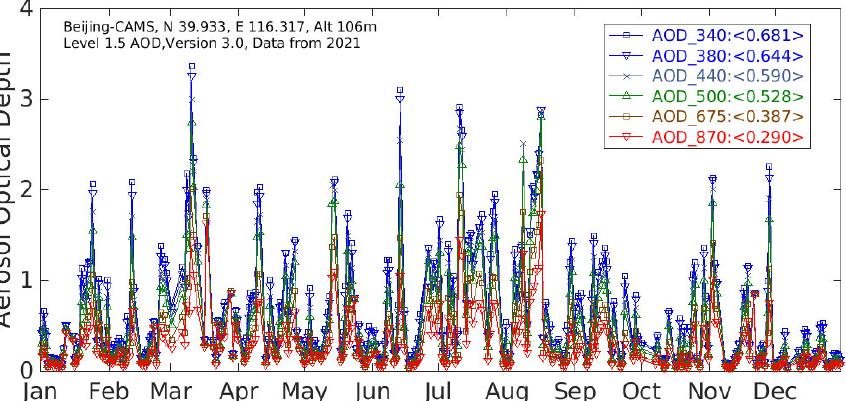
Figure 6. In situ measurements of Aerosol Optical Depth (AOD, daily average) at the NASA AERONET Beijing station shows high AOD in summer months and lower AOD in winter months [20].